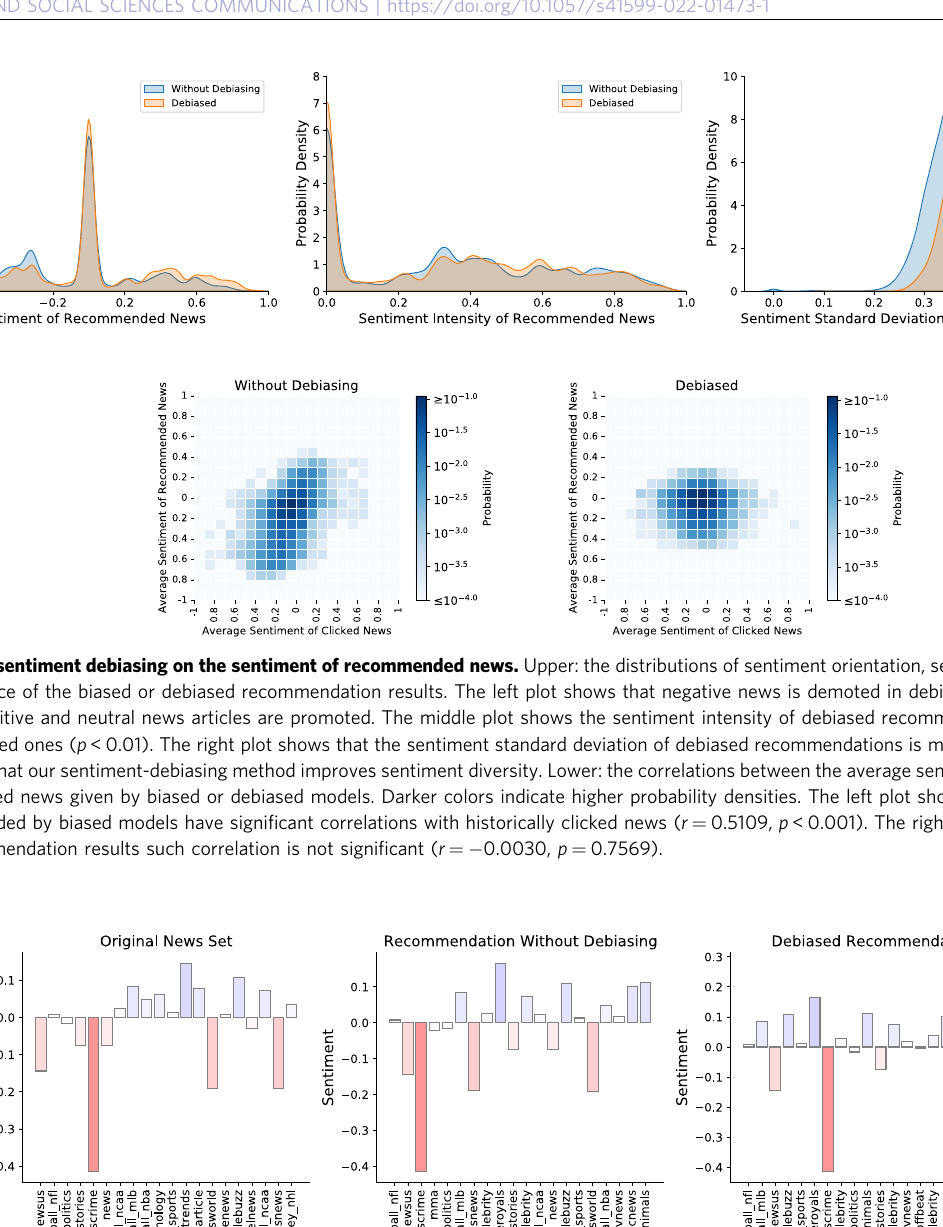
lized news feed services.